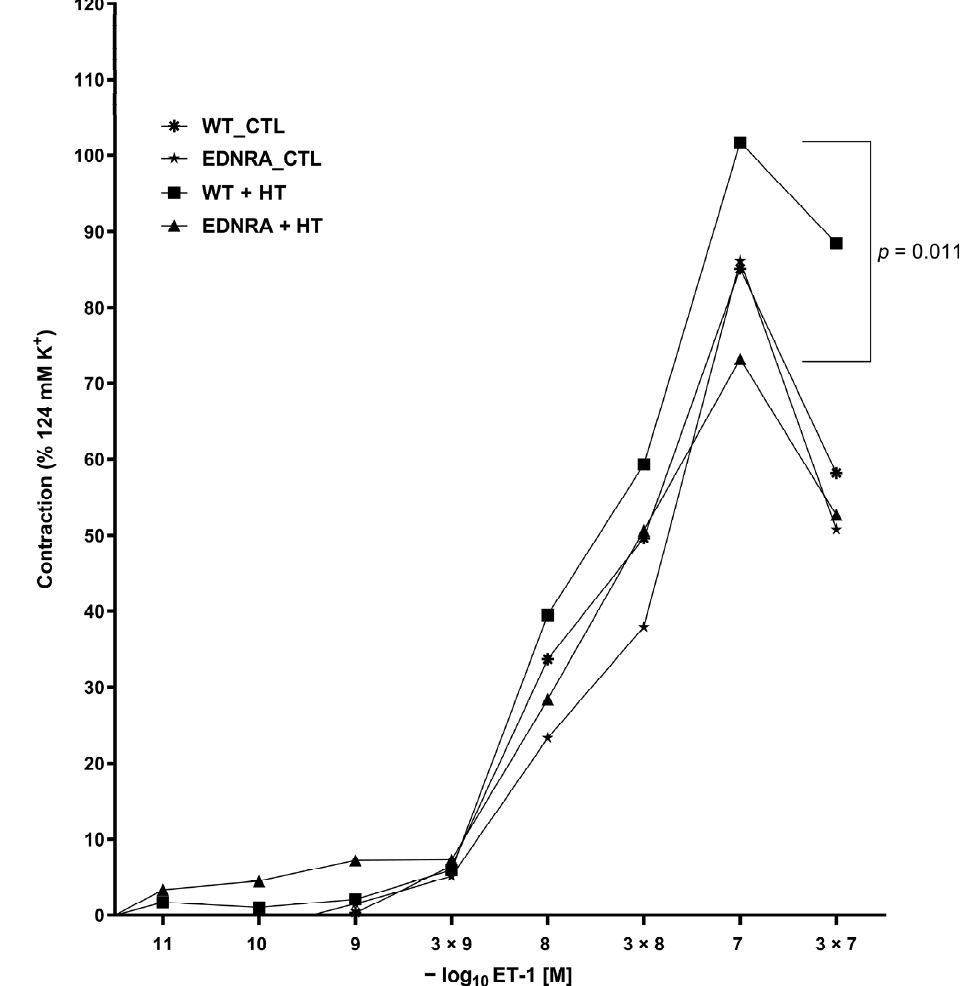
Figure 6. Concentration–response curves (CRCs) for ET-1-induced contraction of BA segments of each group (WT_CTL (N = 9), EDNRA_CTL (N = 19), WT + HT (N = 11), and EDNRA + HT (N = 11)) after observation period of 12 weeks. Maximum contractility was similar in CTL groups, increased in WT + HT (square), and decreased in EDNRA + HT (triangle). Maximum contractilities of WT + HT and EDNRA + HT were significantly different ( p = 0.011). Potency of ET-1 was significantly increased in EDNRA_CTL, whereas potency of EDNRA + HT was equal to both groups of WT rats (see text and Table S5 for detailed data).